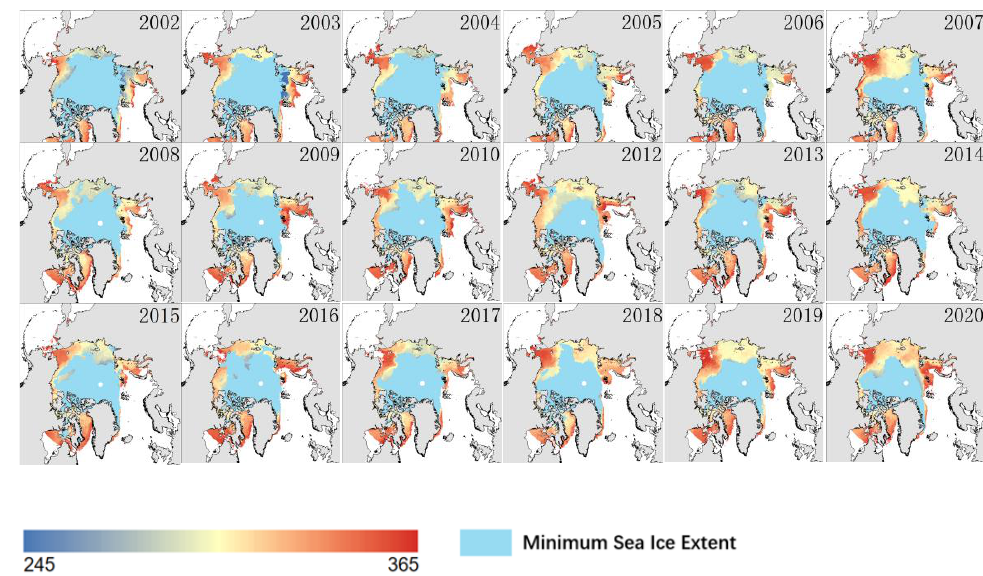
Figure 11. Spatial distribution of Arctic sea ice complete freeze dates (DoY) from 2002 to 2020. Table 8. Days from breaking up to complete melting of Arctic sea ice, 2002 – 2020.